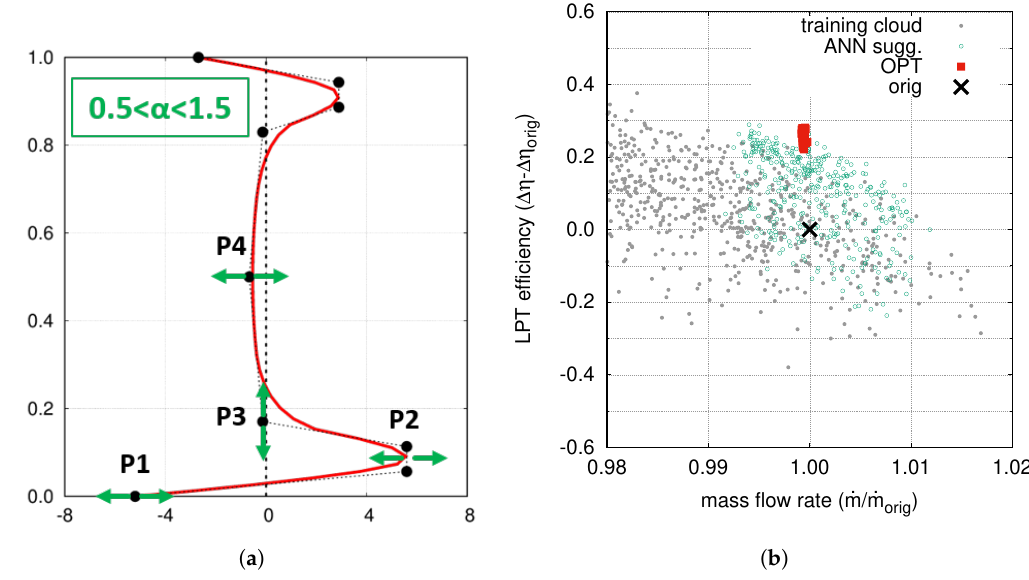
Figure 18. Parameterization ( a ) and computational clouds ( b ) of the LPT redesign